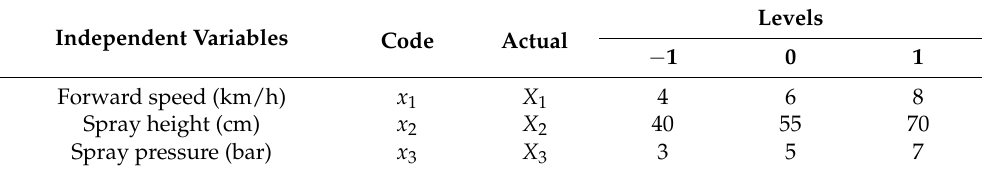
Table 2. Independent variables and their code level in RSM.